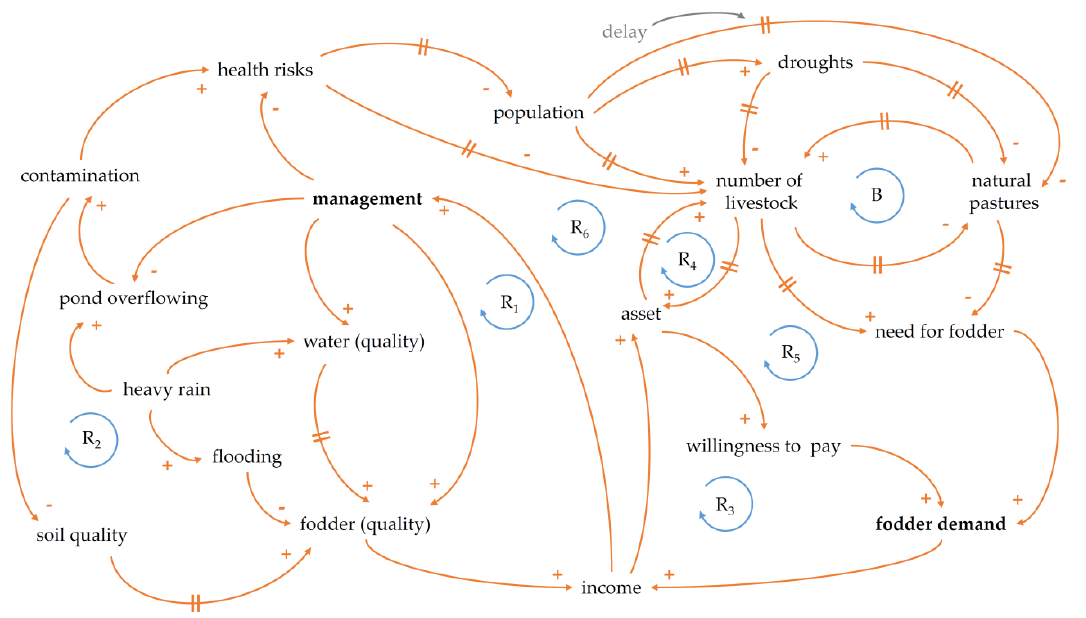
Figure 4. Causal loop diagram of the different system components linked with the main driving forces, management and fodder demand (highlighted). Two strokes on a causal link symbolize a time delay between the current and perceived state of a process. Blue circles containing either an R or a B represent reinforcing or balancing feedbacks.